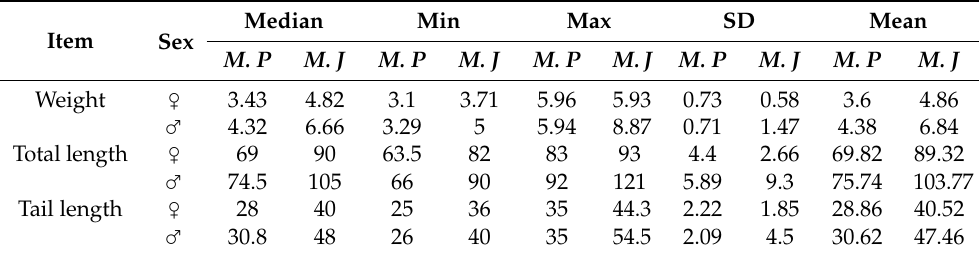
Table 1. Mean, standard deviation (SD), median, and range (Min–Max) of weight, total length, and tail length data of adult pangolins (n M. P = 28, n M. J =